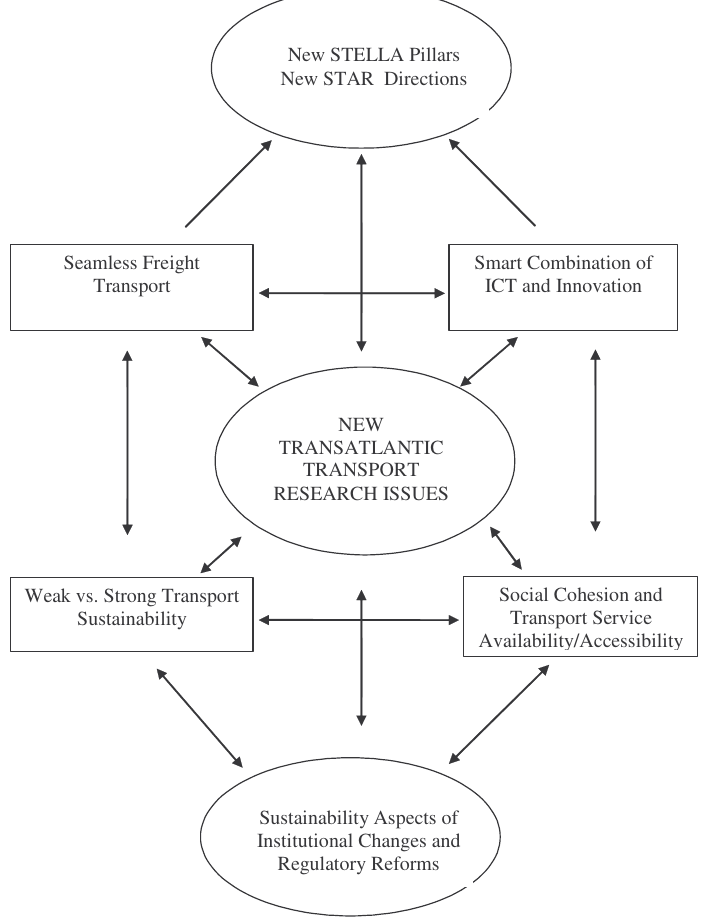
Figure 1. The Architecture of the Special